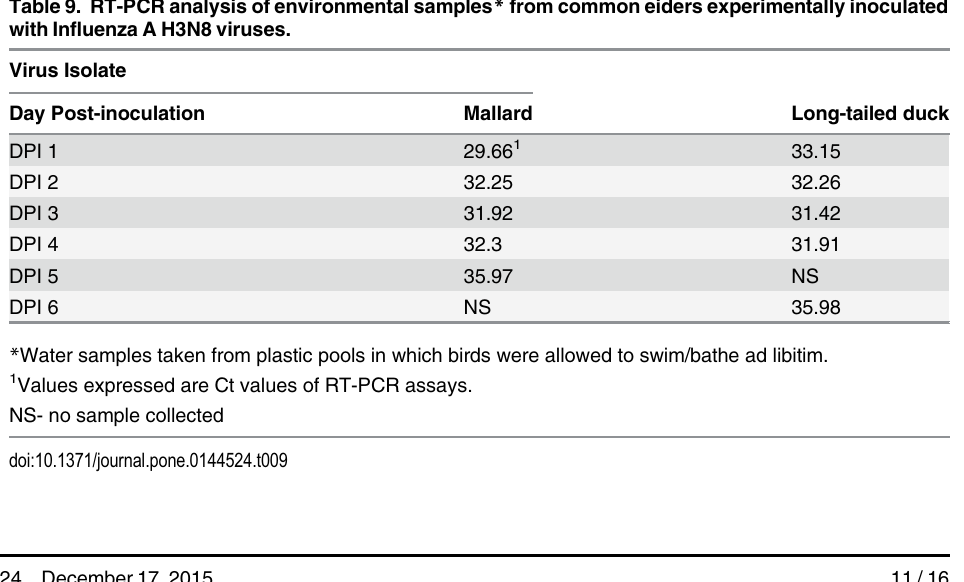
Table 10. All virus challenged common eiders seroconverted by DPI 7 based on bELISA results,